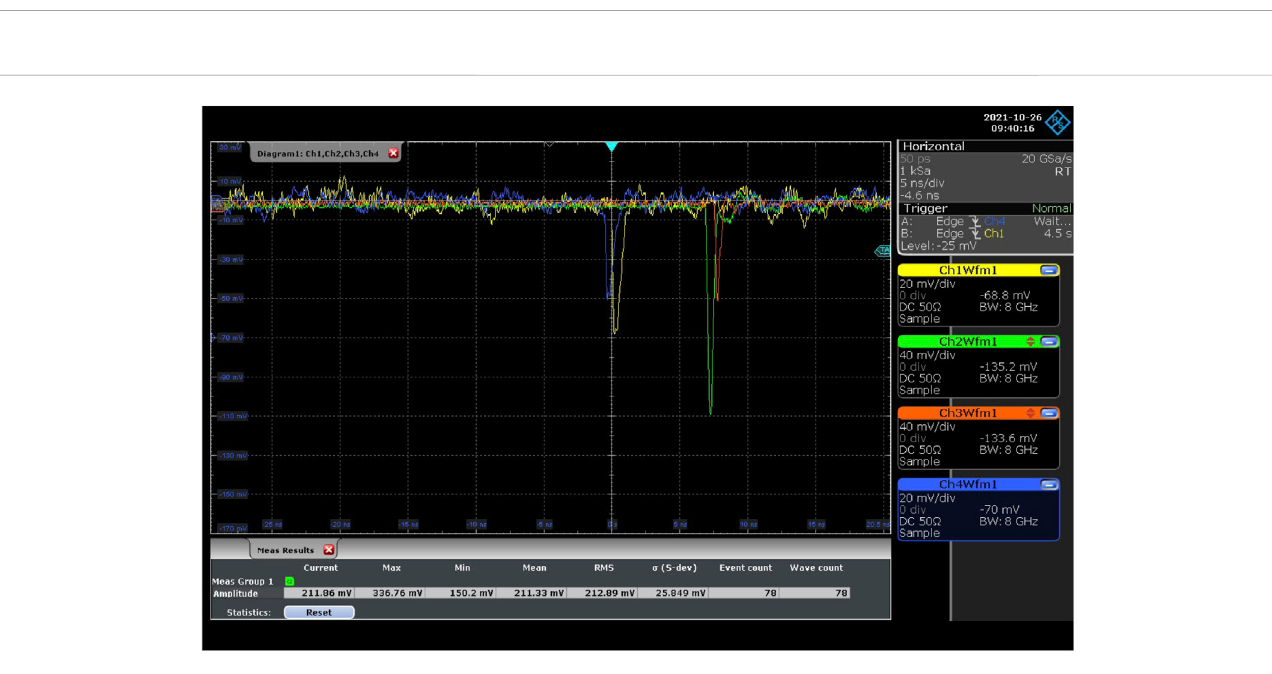
FIGURE 5 Atypicaleventacquiredduringthedatataking.Thesignalsfromthetwosiliconsensorsareshowninyellowandblue,whilethesignalsfromthetwoMCP-PMTs are shown in green and orange. The relative timing between silicon sensors and MCP-PMTs signals is digitally adjusted to optimize the trigger condition